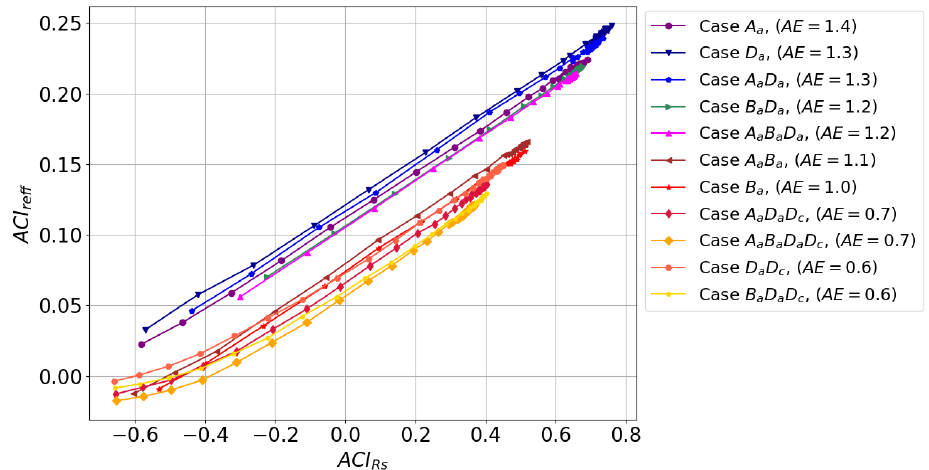
Figure 17. Relation between the ACI ref f with the ACI Rs for different cases with AE from 0.6 to 1.4 ( Z e ≥ − 60